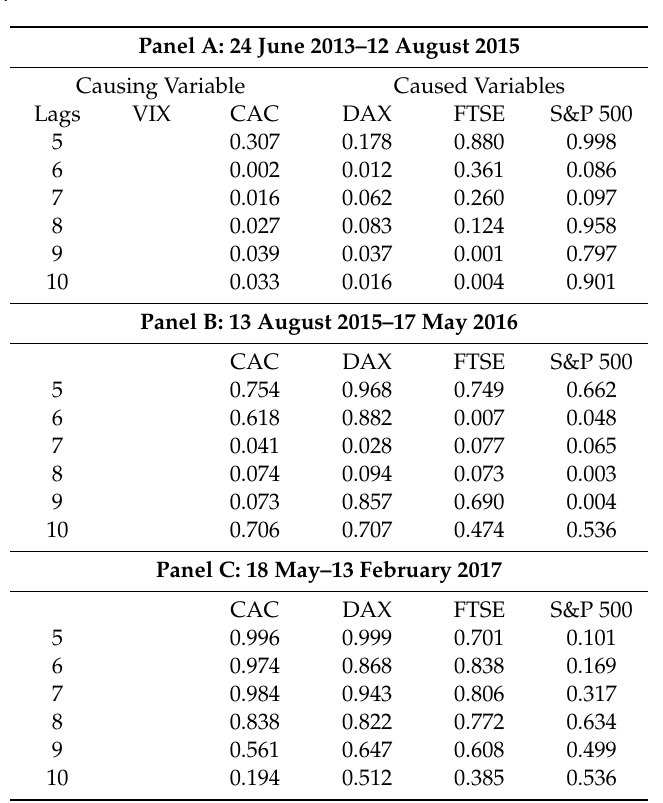
Table 4. Nonlinear Granger causality test: p -values of F statistics for the Ho of no nonlinear Granger